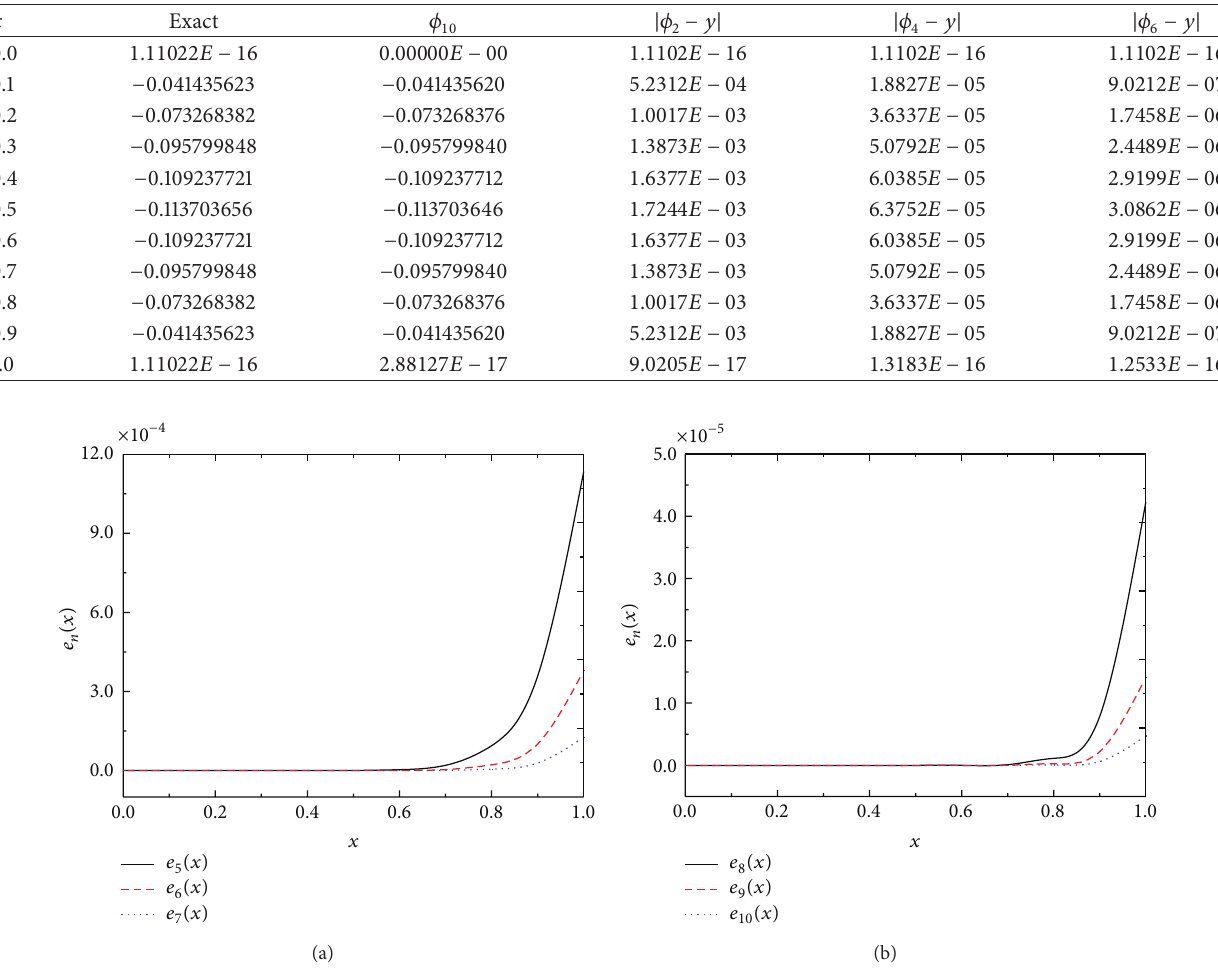
Table 3: Numerical solution and absolute error of Example 6.